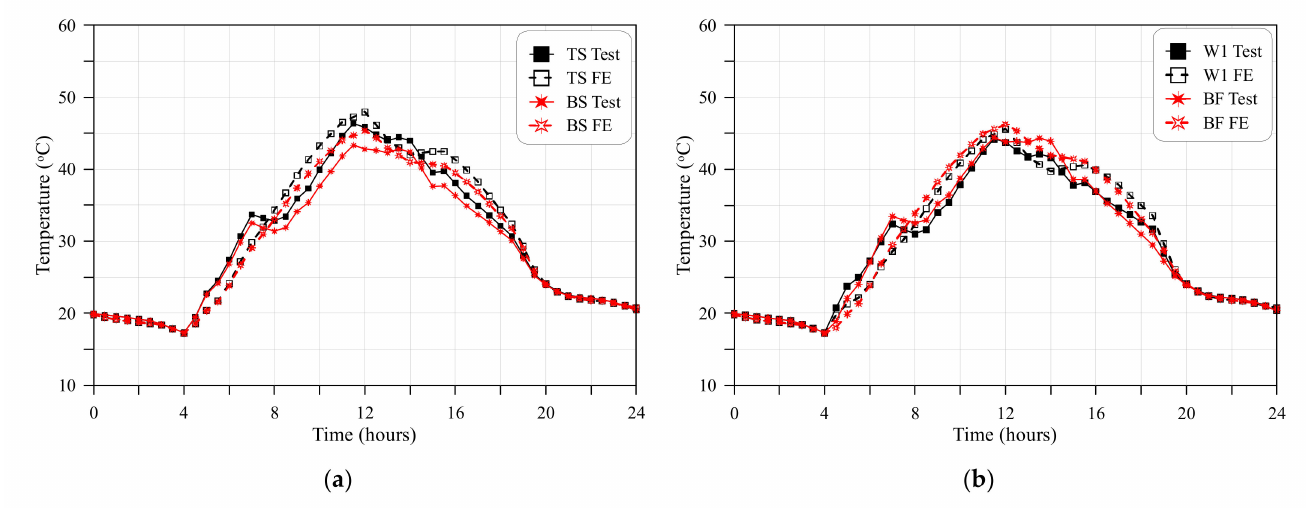
Figure 6. Verification of predicted finite element temperatures with test records: ( a ) TS and BS; ( b ) W1 and